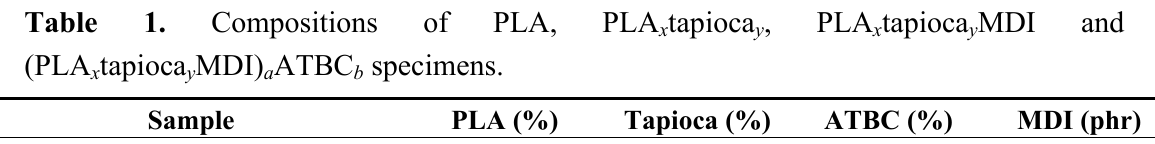
tapioca , PLA tapioca MDI and x y x y